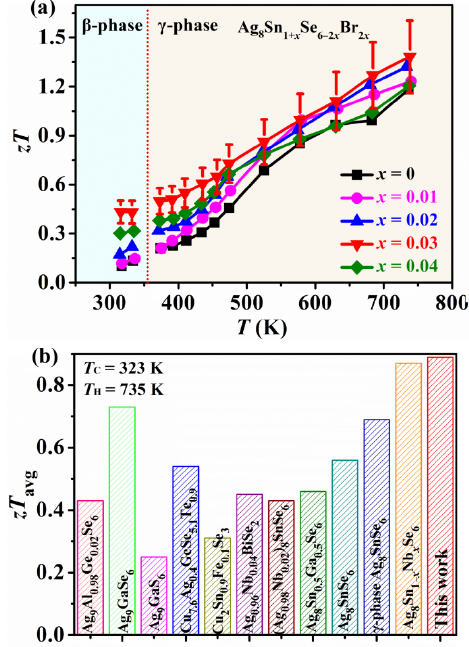
Fig. 6 (a) Temperature dependence of zT for the samples (b) comparison of the zT avg of this work with other argyrodite compounds